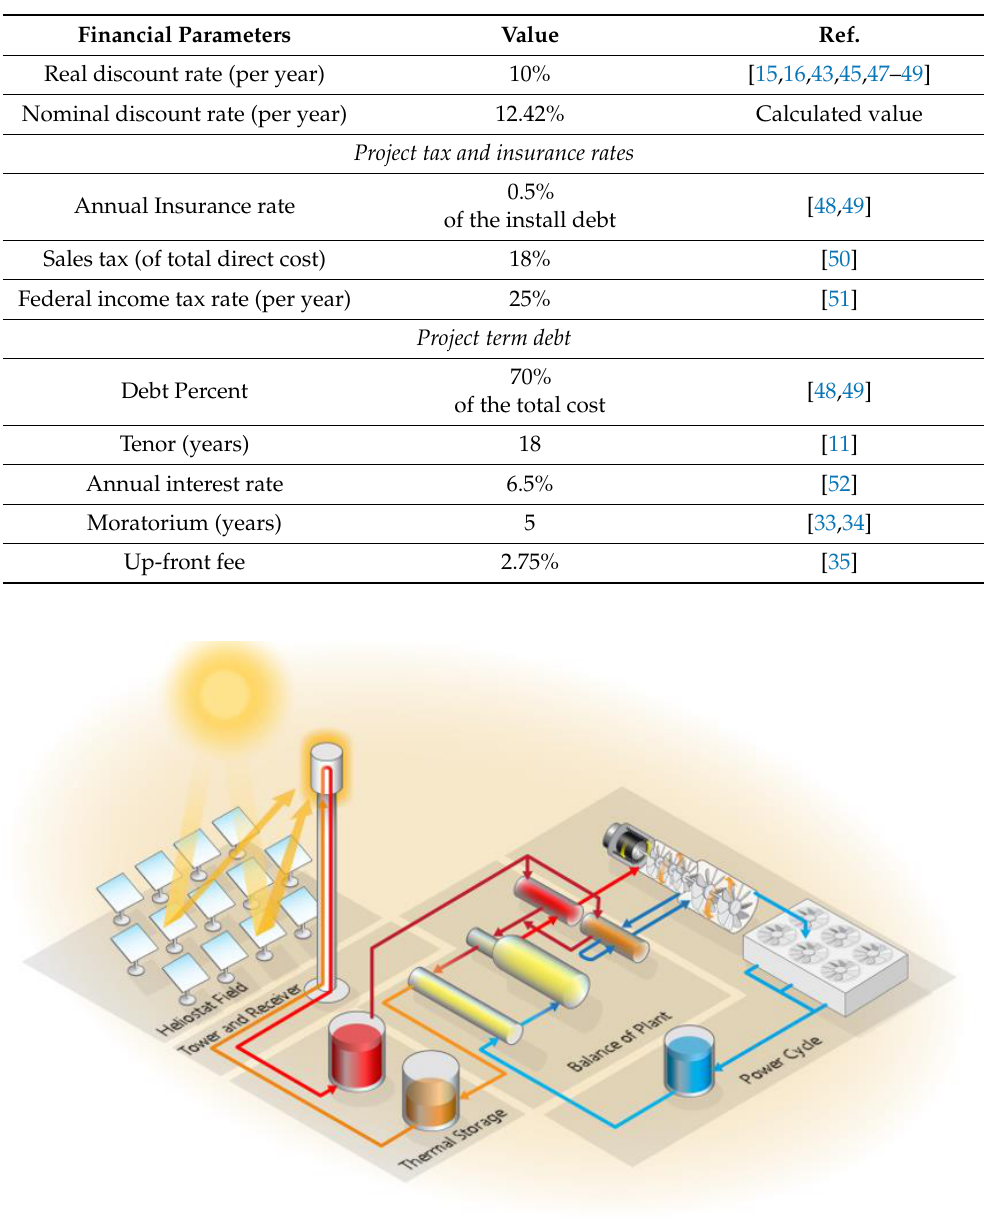
Figure 2. The configuration of the studied STPP technology (obtained from SAM [42]).